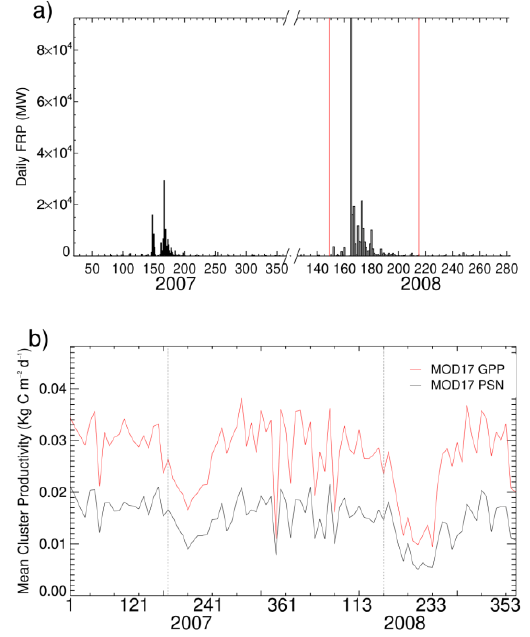
Figure 4. ( a ) Daily fire radiative power (FRP, MW) timeseries from a fire cluster that first burned in 2007 and then again in 2008 in an area of woody savanna in southern hemisphere Africa. The red vertical lines indicate the time period between which FRP retrievals are integrated to estimate the FRE and fuel consumption on the basis of the burned area detection dates. Note that only the time periods where fire activity was detected in each year are shown. ( b ) Mean fire cluster productivity (MODIS Gross Primary Productivity (GPP) and PSN; kg C m -2 day − 1 ). The dashed grey lines indicate the DOY where the fire cluster was last detected as burning in 2007 and first detected as burning in 2008 (according to the MCD64 product), between which the PSN were accumulated. Active fire detection and FRP retrievals are influenced by a number of factors including sensor characteristics, obscuration due to cloud/smoke or an upper canopy, fire size, fuel moisture content